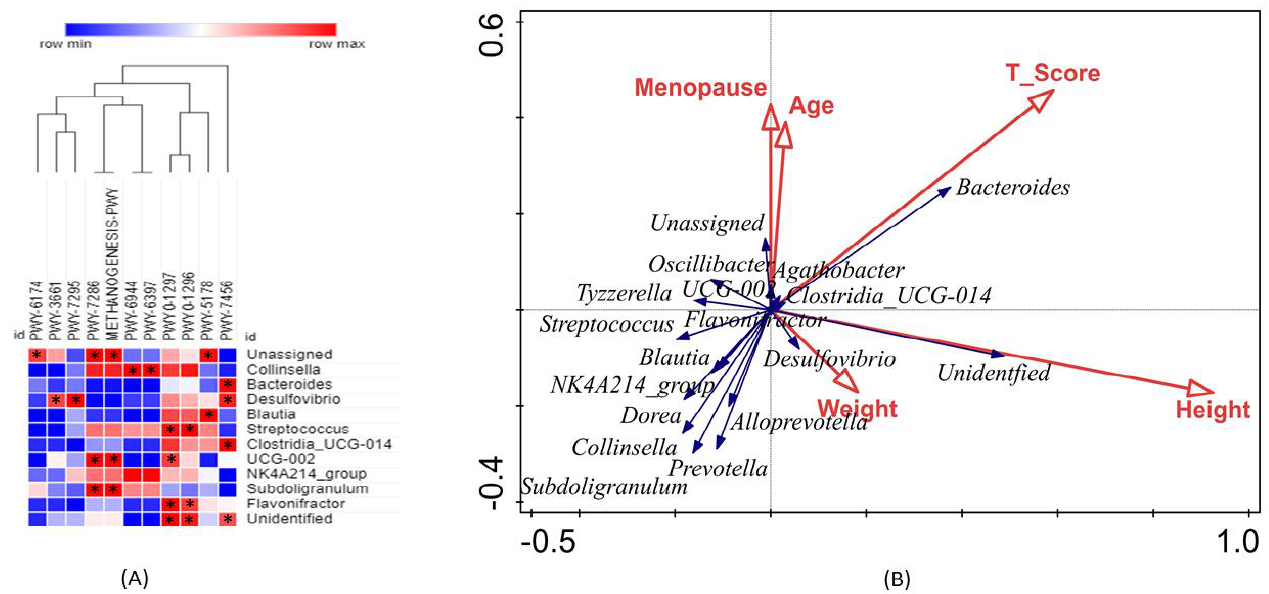
Figure 7. Pearson correlation analysis between the bacterial gut community at genus level and predicted pathways based on 16S rRNA amplicon ( A ). The positive and negative correlations are indicated in red and green colors, respectively, with significance at p < 0.05 as indicated *. Redundancy analysis (B) shows the relationship between the bacterial taxa (blue arrows) and physiological variables (red arrows).